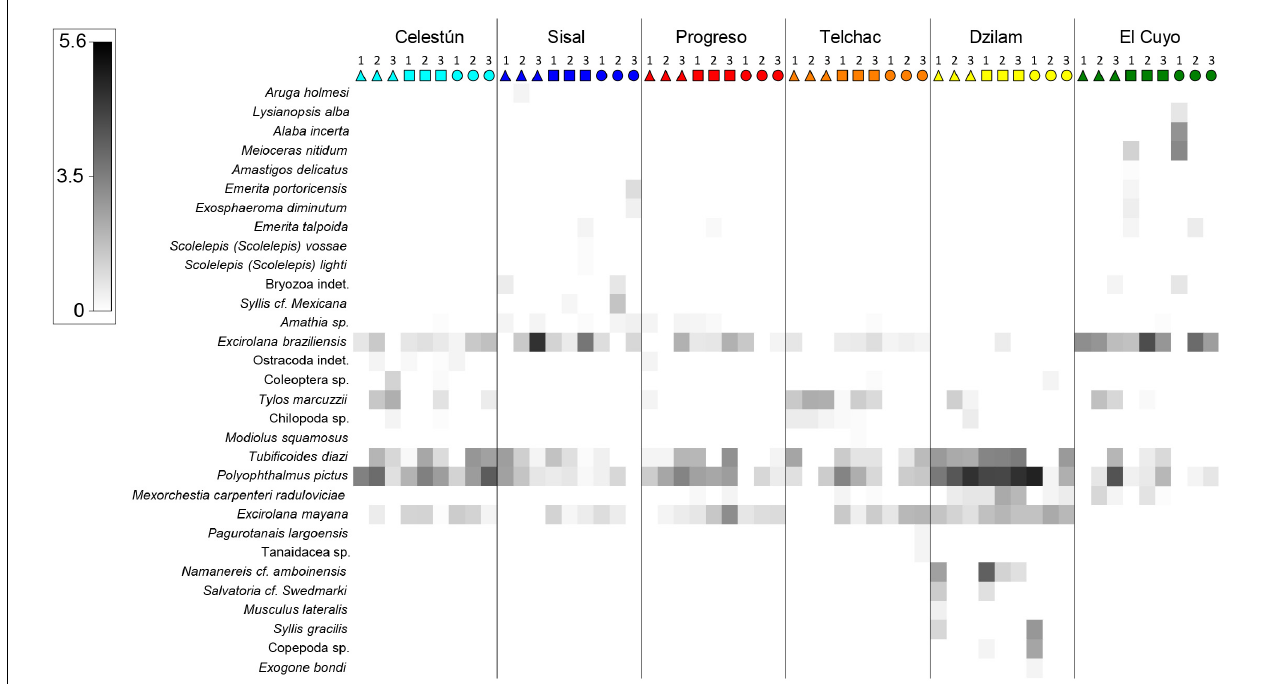
FIGURE 3 | Shade plot of the averaged samples (columns) according to the locality, site (1, 2, 3), and littoral strata (triangle for supra, square for meso, circle for infra), ordered from West to East of the Yucatán coast. The depth of gray shading is linearly proportional to a logarithmic transformation (+1) of the counts of species (e.g., e 5 . 6 – 1 = 269 ind., e 3 . 5 – 1 = 32 ind.). The order of species (rows) corresponds to the similarity of the distribution patterns of the species, based on a hierarchically agglomerative clustering using Whittaker’s index of Association over standardized